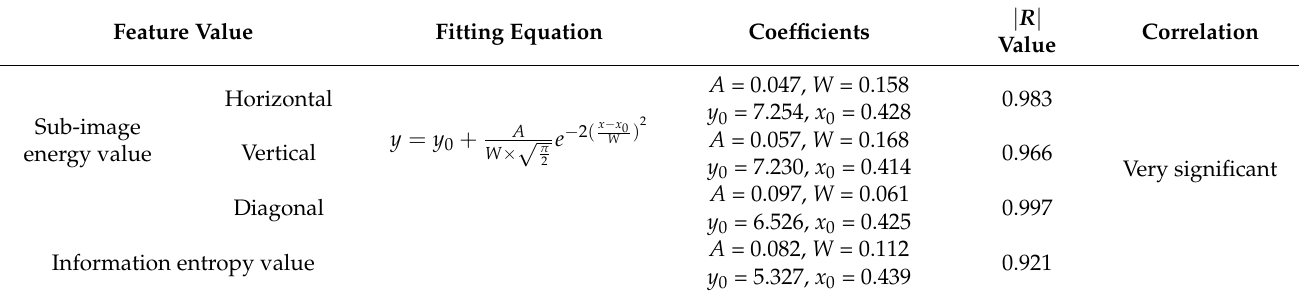
Table 4. Fitting equation and significance test of the relationship between image features after rust removal (sub-image energy value, information entropy value) and corrosion depth. Feature Value Fitting